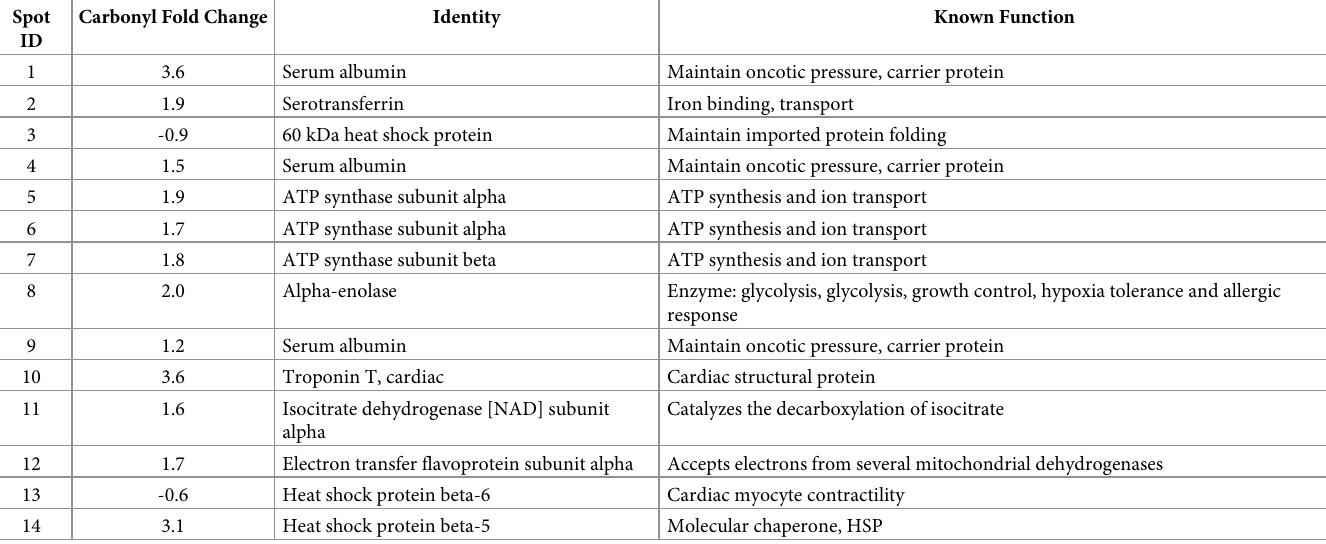
Table 3. Selected proteins from 2D-PAGE gel of male rat myocardium exhibiting change in carbonylation pattern following irradiation. Spot Carbonyl Fold ID